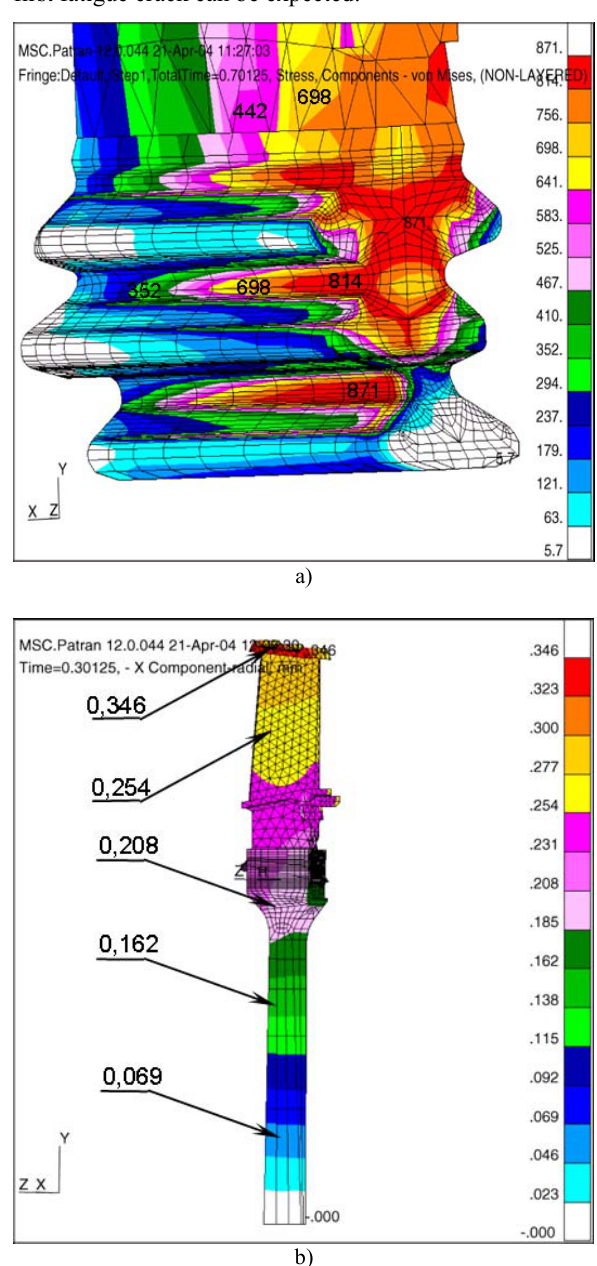
Fig 8 . Von Mises stress distribution in the fir-tree slots of blade (a) radial displacement distribution for disc/blade segment